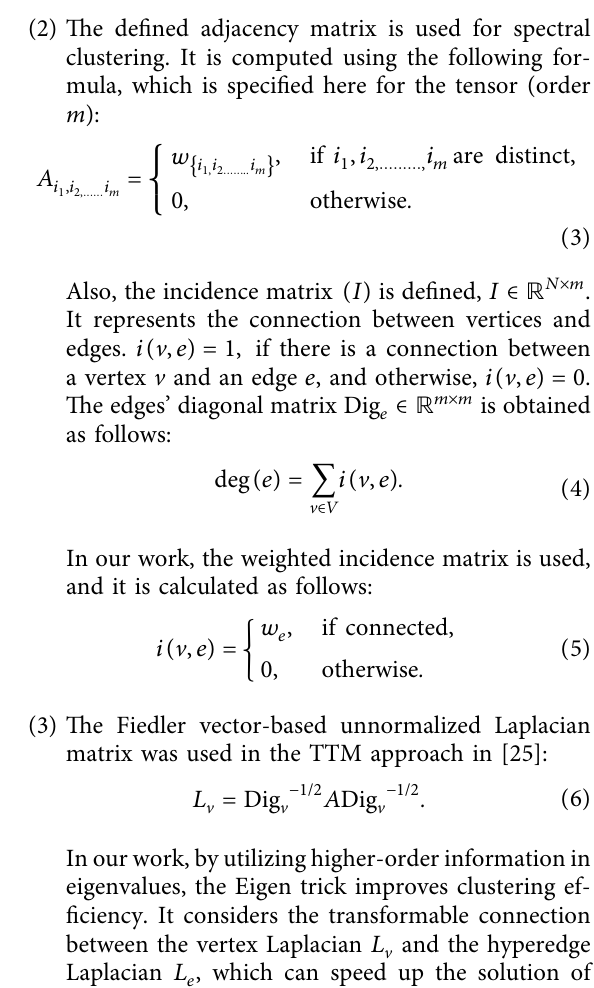
Figure 2: Proposed